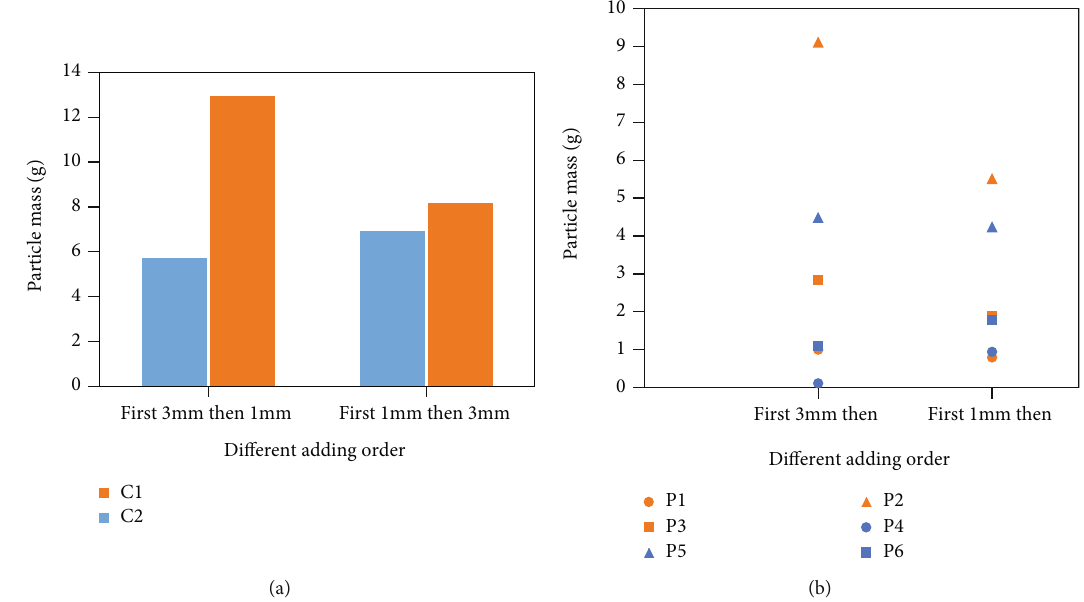
Figure 8: Settlement mass of temporary plugging particles in clusters (a) and perforations (b) under di ff erent adding